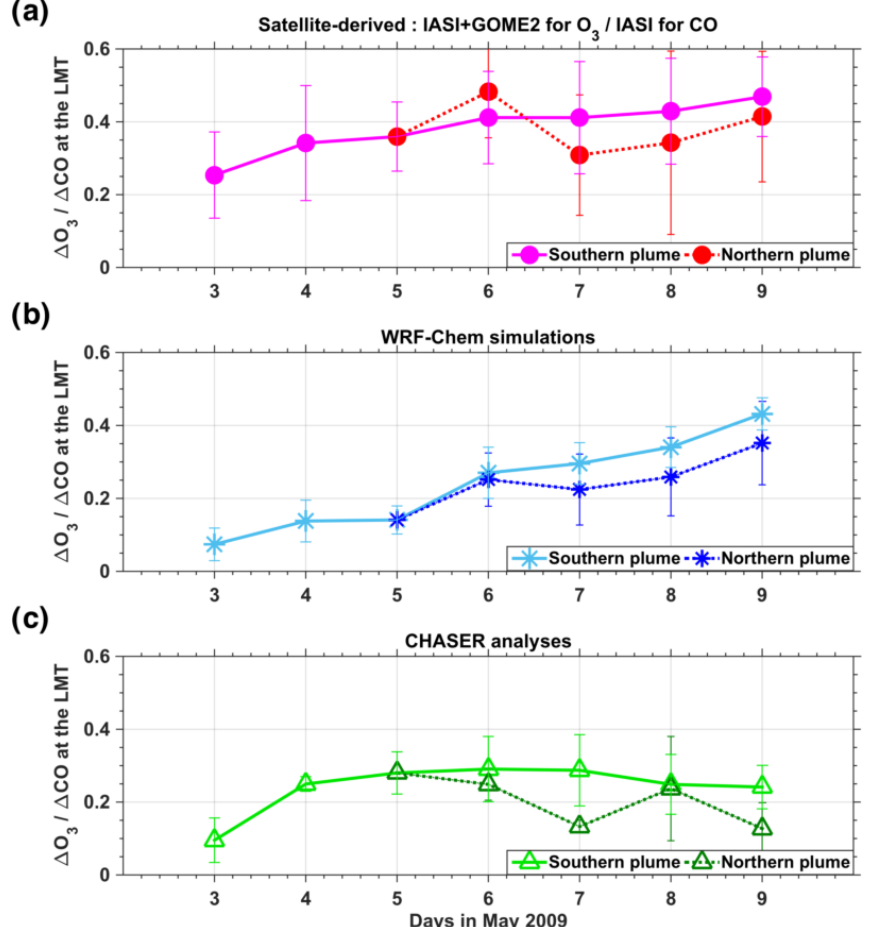
Figure 13. Lagrangian evolution of ozone enhancement during transport described by the ratio (cid:49) O 3 /(cid:49) CO in the LMT for the two pollution plumes tracked across East Asia from 3 to 9 May 2009, derived from (a) IASI + GOME2 O 3 and IASI CO satellite retrievals, (b) WRF-Chem simulations and (c) CHASER analyses. Ratios of (cid:49) O 3 /(cid:49) CO for the southern (northern) pollution plumes are plotted in magenta (dotted red), light blue (dotted blue) and light green (dotted green) in respectively panels (a) , (b) and (c) . Curves show mean and SDs ( ± vertical bars) of (cid:49) O 3 /(cid:49) CO over the areas depicted by rectangles in Figs. 5 and 7–11 for each of the days of the pollution